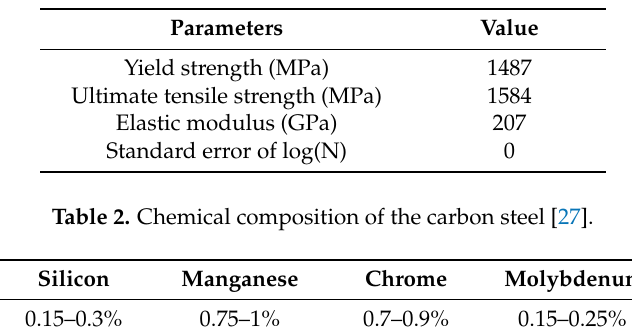
Table 1. Mechanical properties of the carbon steel [27].